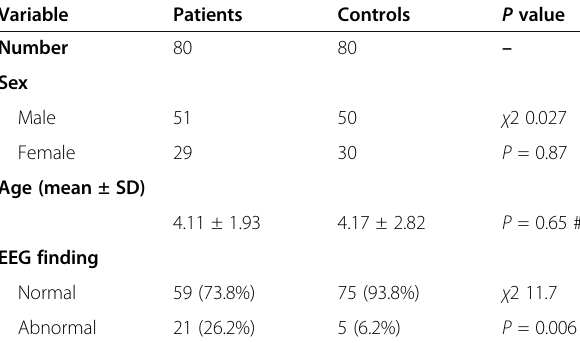
Table 1 Demographic characteristics and EEG activity